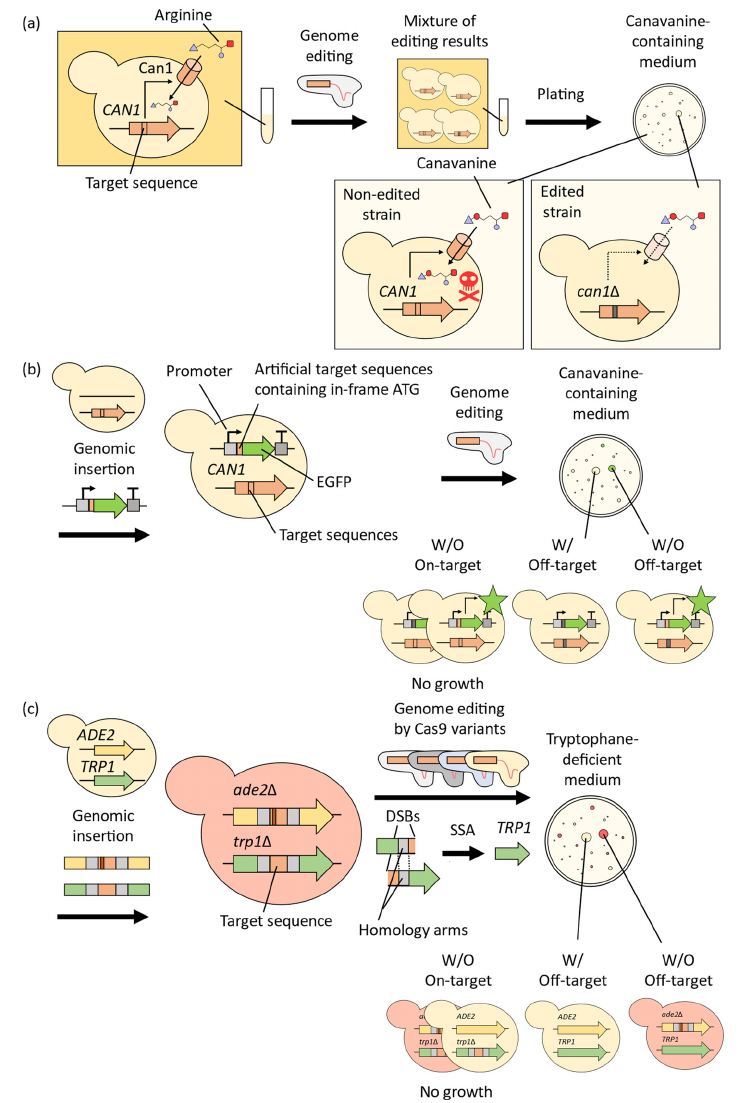
Figure 4. Con fi rmation of CRISPR-Cas9 results using yeast selective marker genes. ( a ) Results of genome editing targeting the CAN1 gene, which encodes a transporter for the toxic compound ca- navanine, can be con fi rmed via growth selection in canavanine-containing medium. ( b ) EGFP se- quence was inserted into the yeast genome after a promoter sequence and an arti fi cial target se- quence with an in-frame start codon. Following genome editing of the arti fi cial target sequence, EGFP expression was disrupted, con fi rming the reduction in o ff -target e ff ects, as evidenced by an increase in the number of cells showing GFP fl uorescence. ( c ) Disruption of ADE2 and TRP1 by an inserted sequence fl anked by homology arms can be repaired by SSA when DSBs are induced via genome editing. Yeast colonies with disrupted ADE2 genes were red because of the accumulation of intermediate metabolites. Therefore, red-colored colonies grown in tryptophan-de fi cient medium expressed the high- fi delity Cas9 variants.